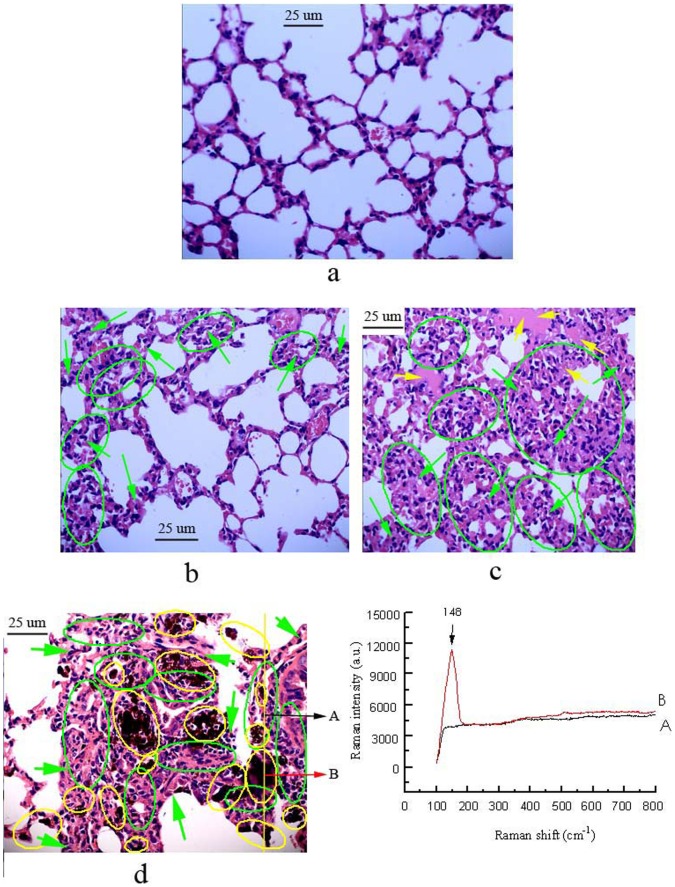
Histopathology of the lung tissue in ICR mice caused by nasal administration of nano-TiO2 for 90 consecutive days.(a) Control group; (b) 2.5 mg/kg BW nano-TiO2 group indicates inflammatory cell infiltration (green cycles) and thickening of pulmonary interstitium (green arrows); (c) 5 mg/kg BW nano-TiO2 group indicates severs inflammatory cell infiltration (green circles), and great thickening of pulmonary interstitium (green arrows) and pulmonary edema (yellow arrows); (d) 10 mg/kg BW nano-TiO2 group indicates severe inflammatory cell infiltration (green arrows) and great thickening of pulmonary interstitium (green arrows), yellow circles show black deposition in the lung. Arrow A spot is a representative cell that not engulfed the nano-TiO2, while arrow B spot denotes a representative cell that loaded with nano-TiO2. The right panels show the corresponding Raman spectra identifying the specific peak at about 148 cm-1.